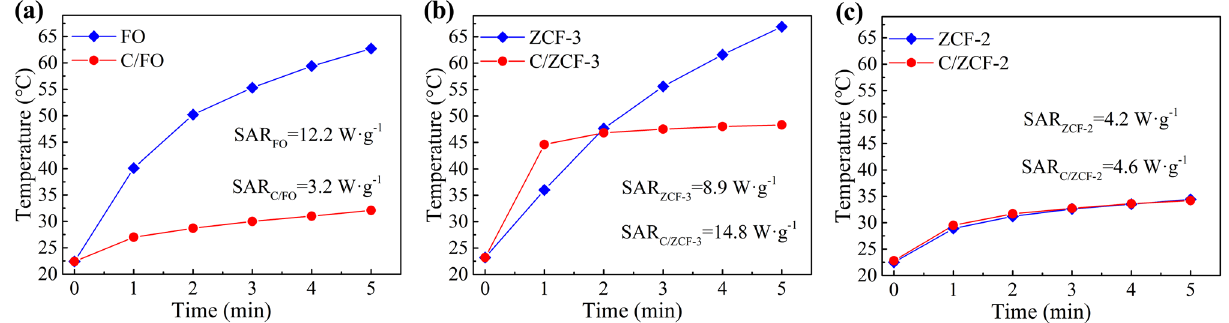
Figure 5. The magnetic heating curves of the samples under the AMF with 24 kA/m and 100 kHz: ( a ) FO and C/FO, ( b ) ZCF-3 and C/ZCF-3, ( c ) ZCF-2 and C/ZCF-2.